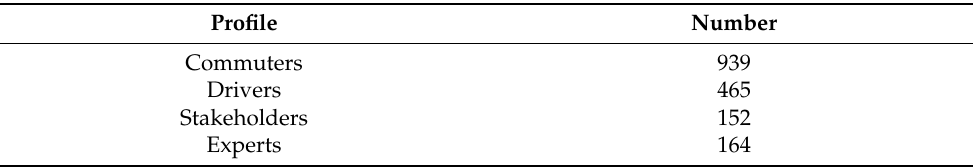
Table 1. Summary of